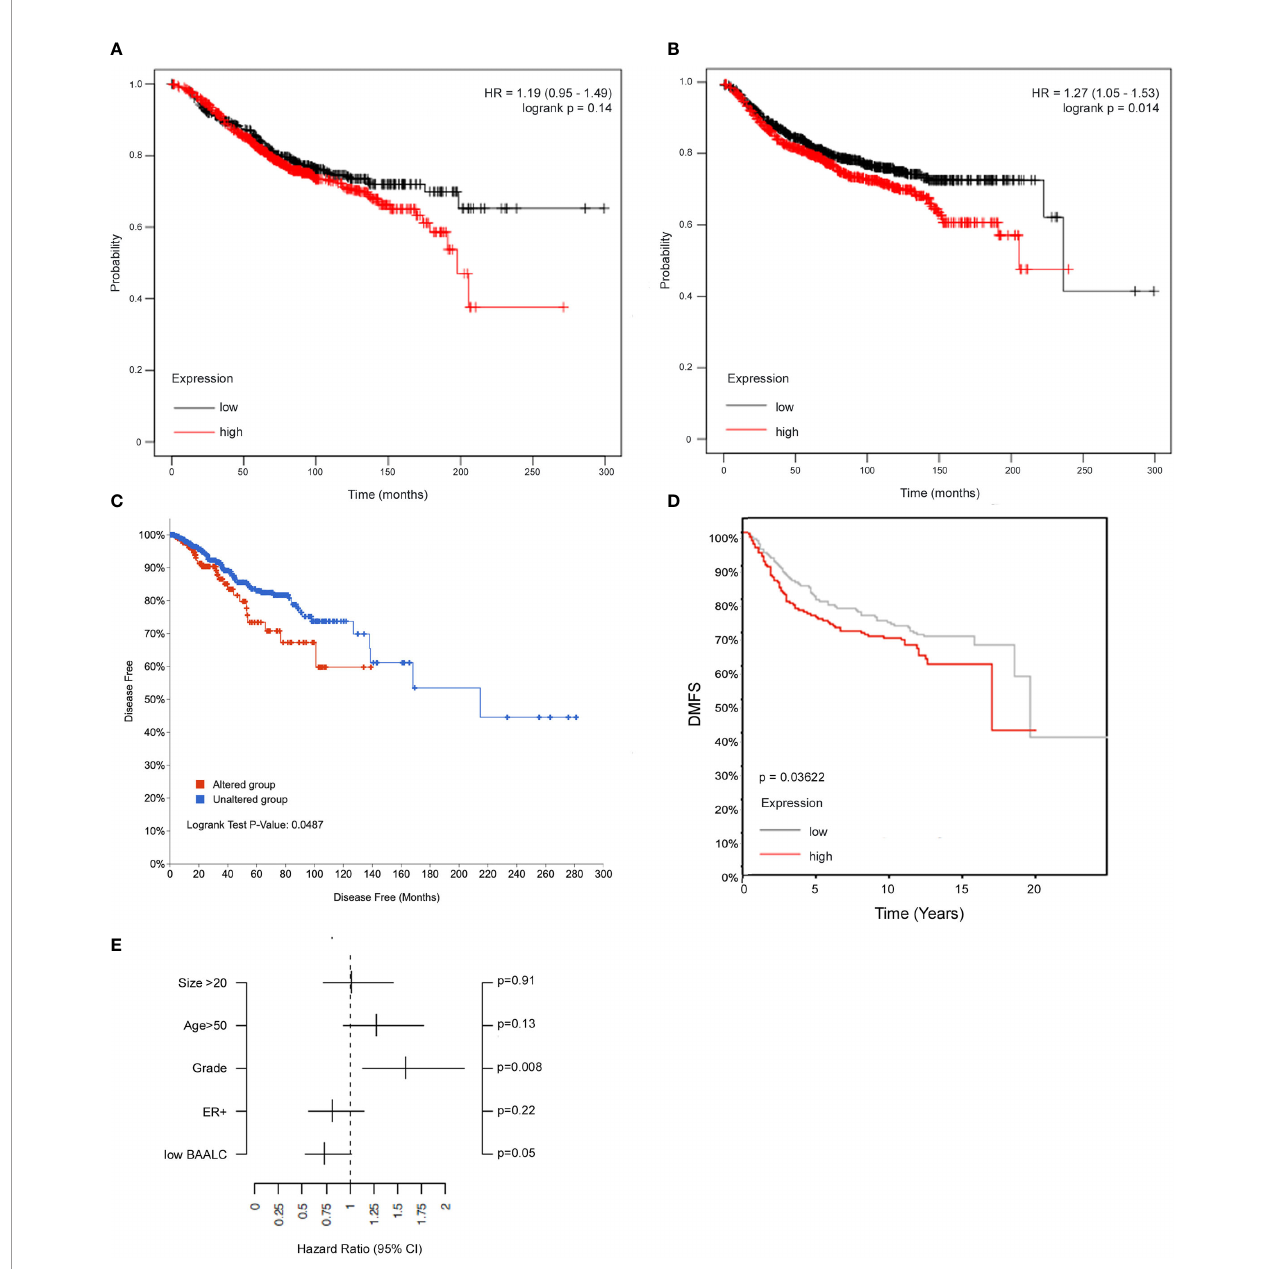
FIGURE 2 | High BAALC predicts for worse progression free and distant metastasis free survival in breast cancer patients. Kaplan-Meier curves showing the (A) overall survival and (B) distant metastasis-free survival in a publicly available 3,935-sample breast cancer data set (32) with elevated (red) or low (black) expression of BAALC in breast cancer tumors when assessing all tumor subtypes together. Kaplan-Meier curves showing the (C) disease-free survival in a publicly available 960- sample breast cancer data set (33), with high (red) or low (blue) expression of BAALC . Kaplan-Meier curves showing the (D) distant metastasis free survival in a publicly available 821-sample breast cancer data set (34), with high (red) or low (gray) expression of BAALC . (E) Multivariate analysis for the Kaplan-Meier analysis shown in (D) , using estrogen receptor (ER)-status, tumor size, age, histological grade and low BAALC as covariates, distant metastasis free survival as endpoint with no time- dependent censoring. The hazard ratio and the 95% con fi dence interval are plotted for each of these covariates. p values were computed by a log-rank